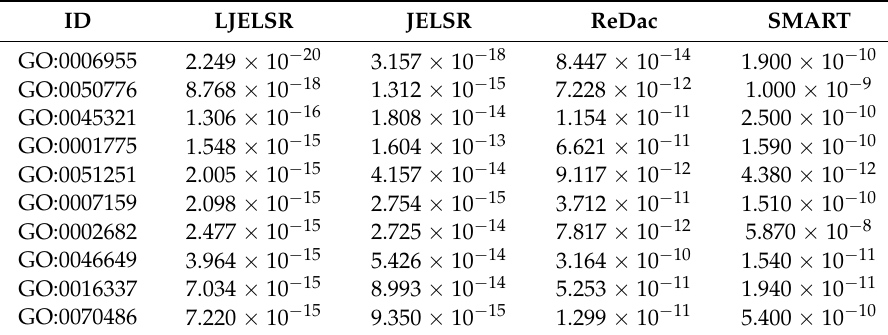
Table 2. The p -values of different methods applied to the ALL_AML dataset.